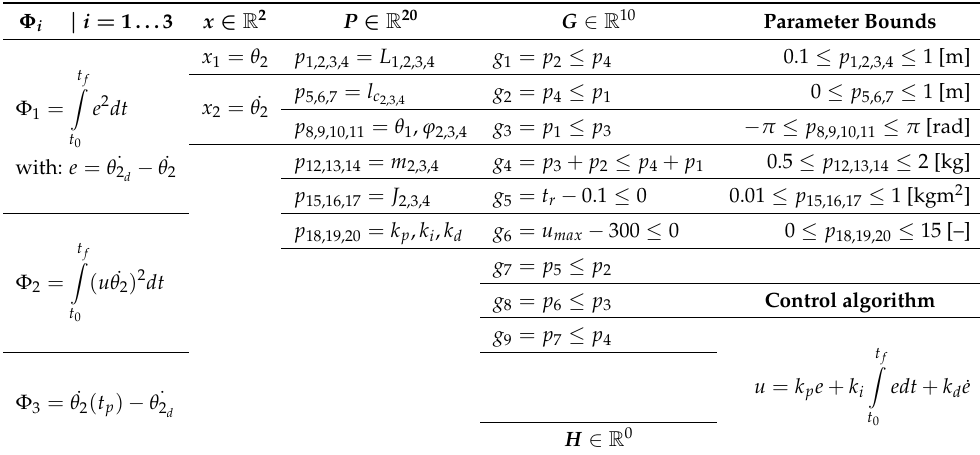
Table 2. Summary of data for the optimization problem formulation for the case of study in Figure 7.